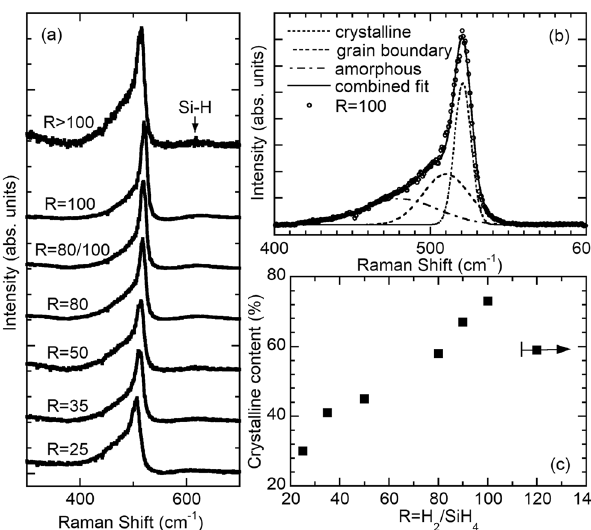
Fig. 2 Raman spectra: intensity vs. Raman energy shift. a Raman spectra of all seven plasma-enhanced chemical vapor-deposited nc -Si fi lms. The y - axes are shifted for clarity. A faint peak at ~615 cm − 1 caused by vibrations of Si – H bonds is indicated. b The empirical fi ttings for R = 100. Contributions from amorphous, grain boundary, and crystalline phases are shown separately. c The crystalline content vs. R for all seven fi lms. The right arrow indicates the uncertainty of R for R > 100 explained in the “ Results ”